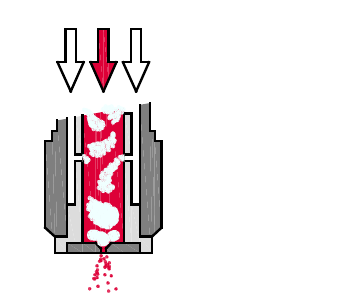
Figure 9. Internal plug flow pattern estimated for the OIG atomizer at GLR = 2.5%, µ l = 60 mPa ·